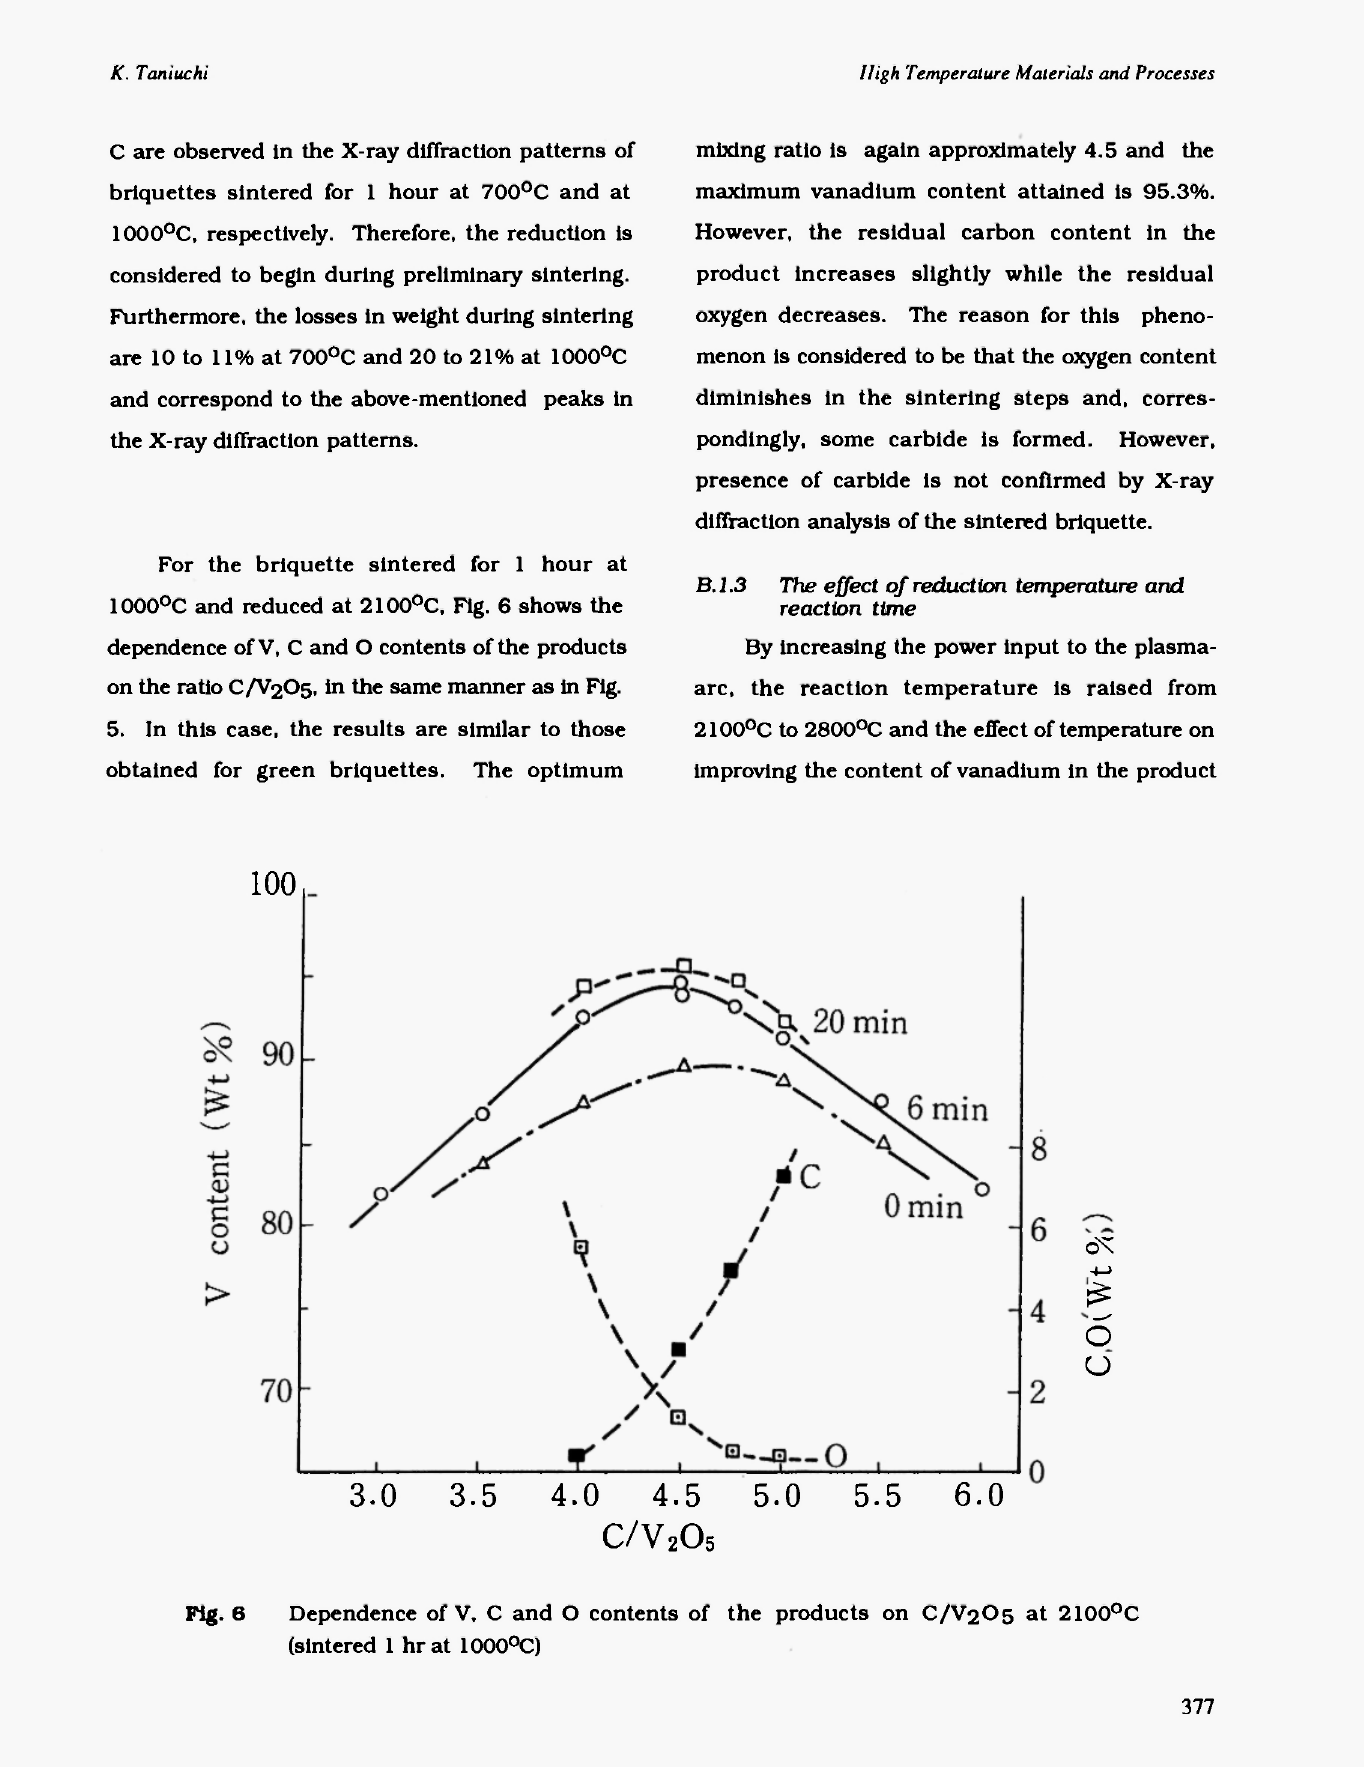
Fig. 6 Dependence of V, C and Ο contents of the products on C/V2O5 at 2100°C (sintered 1 hrat